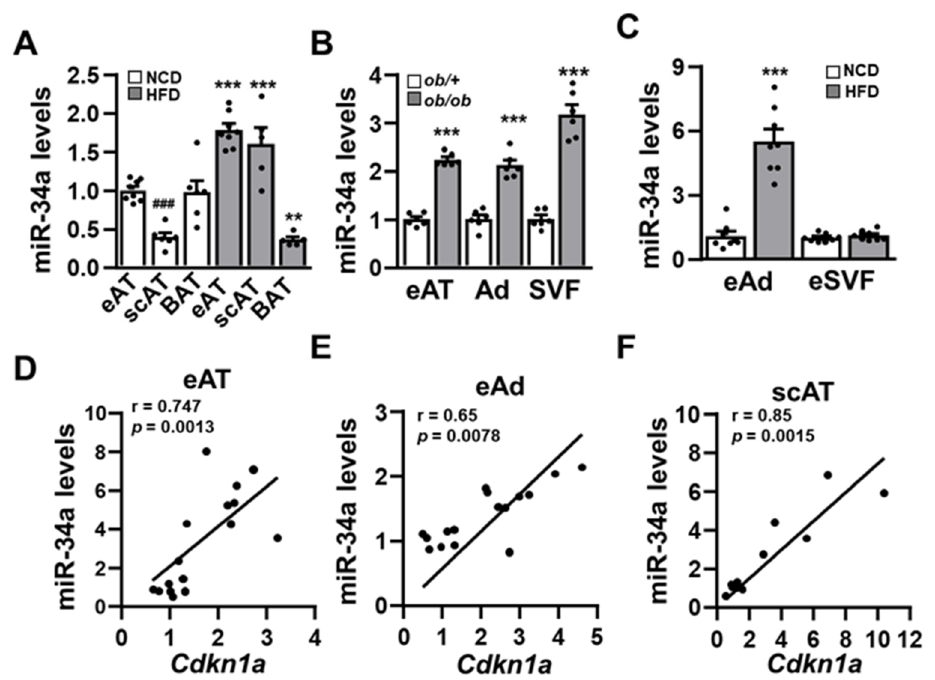
Figure 1. miR-34a expression is increased in adipose tissues and adipocytes of obese mice: Relative expression level (qPCR) of miR-34a ( A ) in epididymal white adipose tissue (eAT), subcutaneous white adipose tissue (scAT), and brown adipose tissue (BAT) of mice ( n = 5–8) fed with normal chow diet (NCD) or a high-fat diet (HFD) for 13 weeks; ( B ) in eAT, adipocytes (Ad) and stromal vascular fraction (SVF) of genetically obese ob/ob mice and their lean ob/+ littermates ( n = 6), and ( C ) in adipocytes and eSVF of eAT isolated from mice on NCD or HFD for 13 weeks. ( D – F ) Corre- lation analysis of miR-34a and Cdkn1a mRNA levels in the indicated white adipose tissue or adi- pocyte fraction. ANOVA with Bonferroni’s multiple comparisons test was used for A and B. Cor- relation was assessed by non-parametric Spearman’s test. Bar graphs are mean values ± SEM. ** p < 0.01 and *** p < 0.001 NCD vs. HFD; ### p < 0.001 scAT vs. eAT. Relative levels of miR-34a and Cdkn1a mRNA were normalized to sno208 and Rplp0 ( 36B4 ), respectively. 3.2. The Overexpression of miR-34a in Adipocytes Inhibits Insulin-Induced Glucose Transport and VAMP2 Expression Because miR-34a expression is increased in the adipocytes of obese mice, we deter- mined the consequences of miR-34a overexpression on insulin signaling and actions in adipocytes. To this aim, 3T3-L1 adipocytes were transiently transfected with a mimic of miR-34a or a control miRNA and then incubated without or with insulin (0.5, 1, 10 nM) before measurement of deoxyglucose (DOG) uptake. The overexpression of miR-34a re- duced insulin-induced glucose uptake both at a maximal and submaximal concentration of insulin (Figure 2A). This inhibition occurred without any changes in the expression of GLUT4 or GLUT1 (Figure 2B,C). Strikingly, the expression of the v-SNARE protein VAMP2, which is involved in the fusion of GLUT4-containing vesicles with the plasma membrane [35], and described as miR-34a target in pancreatic β cells [26], was decreased in 3T3-L1 adipocyte overexpressing miR-34a (Figure 2D) as well as in the adipose tissue of HFD-fed mice (Figure 2E), while its mRNA expression level was not significantly re- duced (Figure 2F).